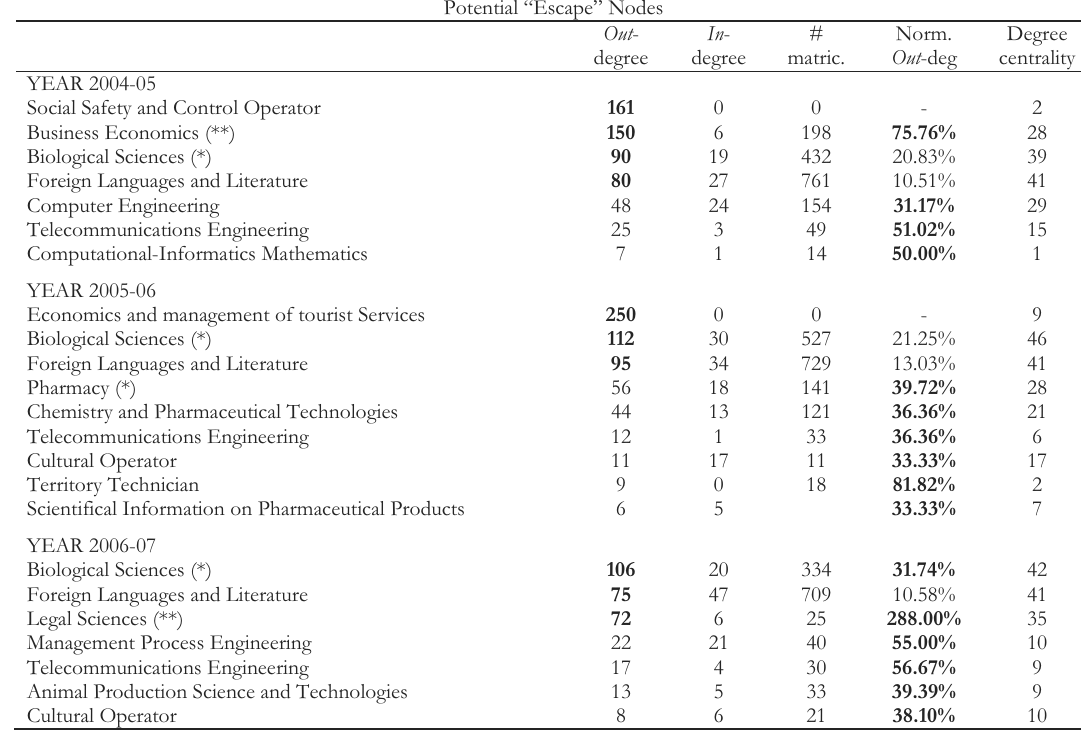
Potential “Escape” degree courses Potential “Escape” Nodes